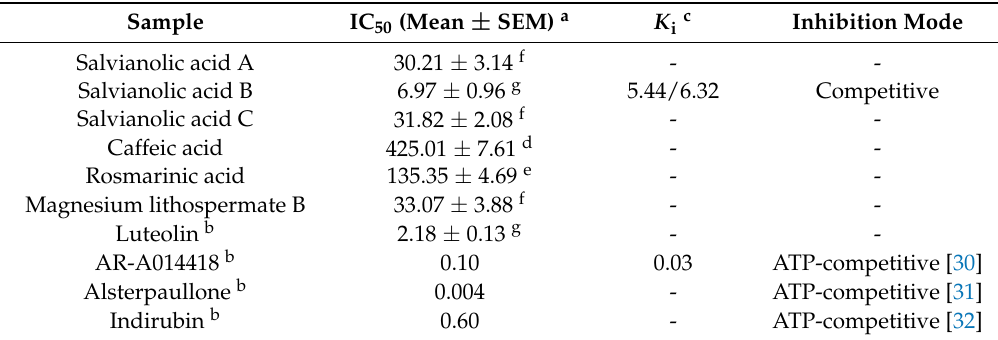
Table 2. Glycogen synthase kinase 3 β inhibitory potentials of polar compounds from water extract of Salvia